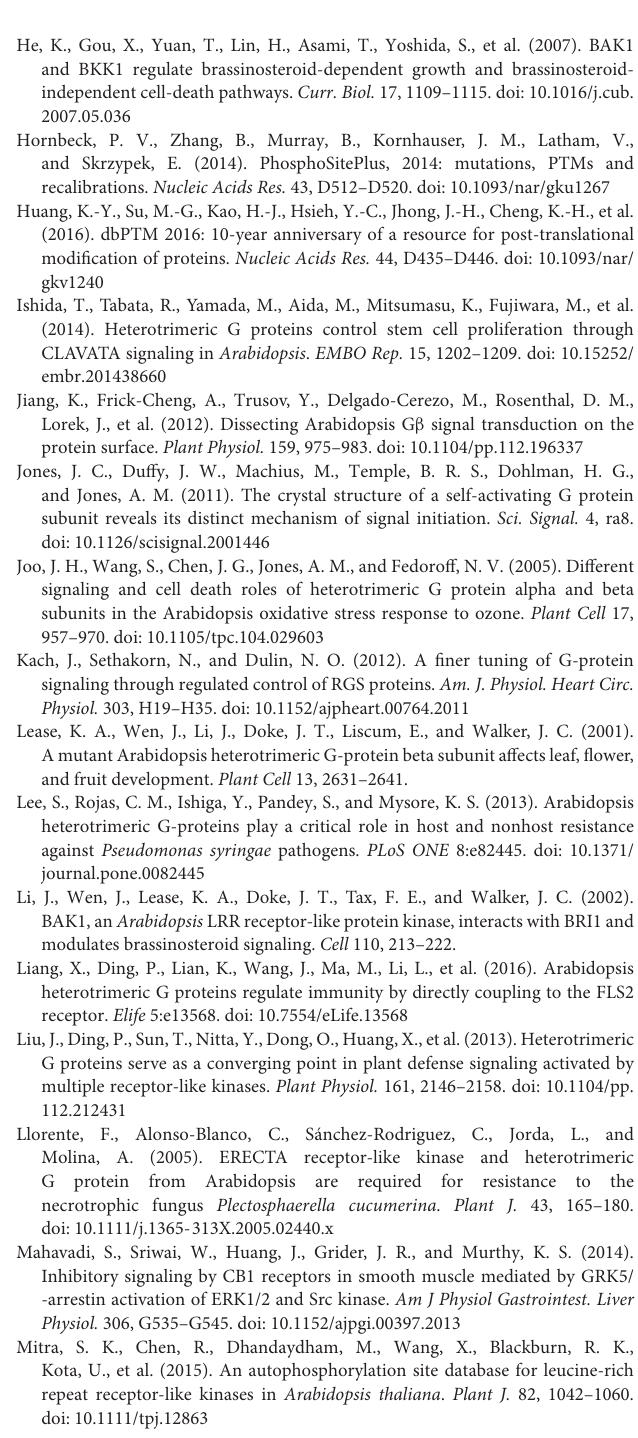
TABLE S1 | Comprehensive table of PTMs found in clusters around plant phosphosite MAPs. TABLE S2 | Comprehensive table of plant phosphosite features derived from the plant and PTM sub-alignments. TABLE S3 | Table of MAPs found in the RGS